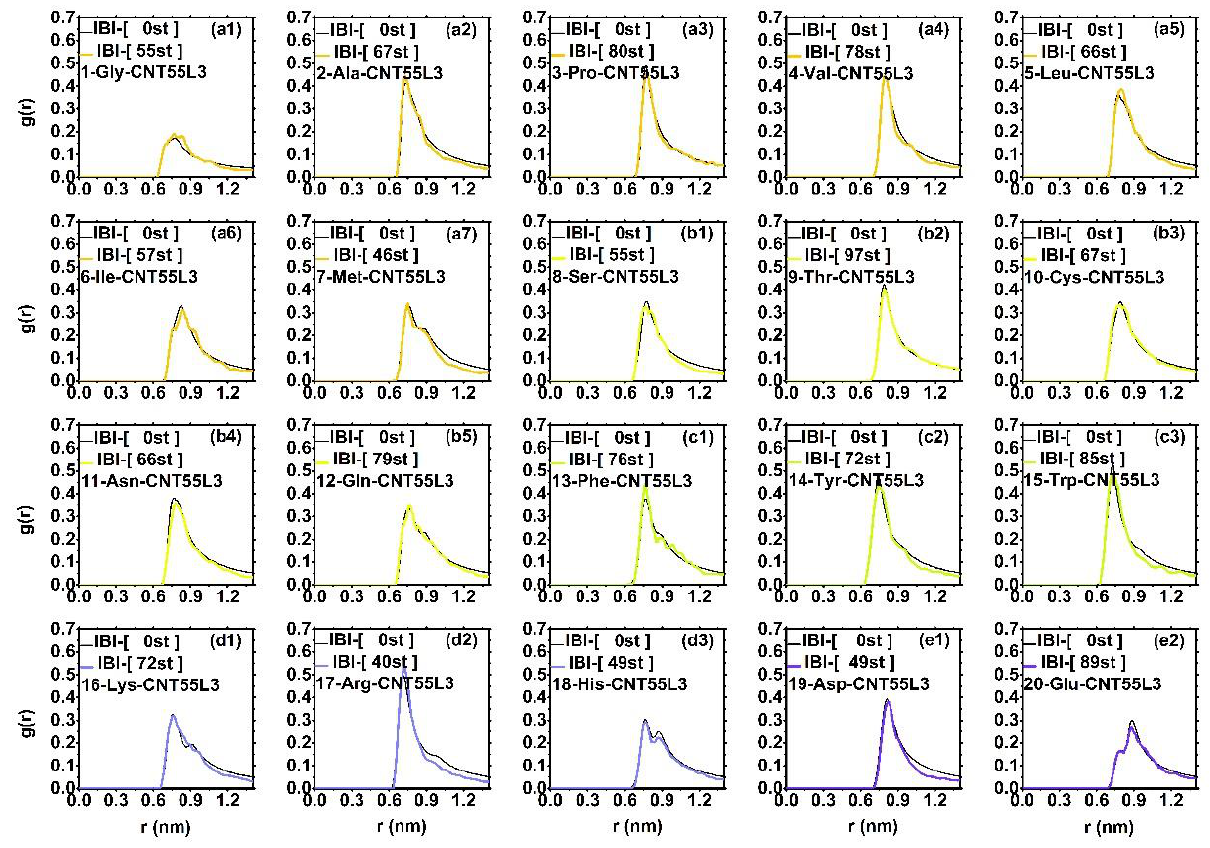
Figure 5. The radial distribution function and target radial distribution function between 20 amino acids and CNT55L3 obtained after IBI iterative optimization. The black lines in each figure are their respective target RDF, and ( a1 – a7 ) are the non-polar RDF of the amino acid group, the line color is orange; ( b1 – b5 ) is the RDF of the polar uncharged amino acid group, the line color is yellow; ( c1 – c3 ) is the RDF of the aromatic amino acid group, the line color is green; ( d1 – d3 ) is the RDF of the positively charged amino acid group, the line color is blue; ( e1 , e2 ) is the RDF of the negatively charged amino acid group, the line color is purple.